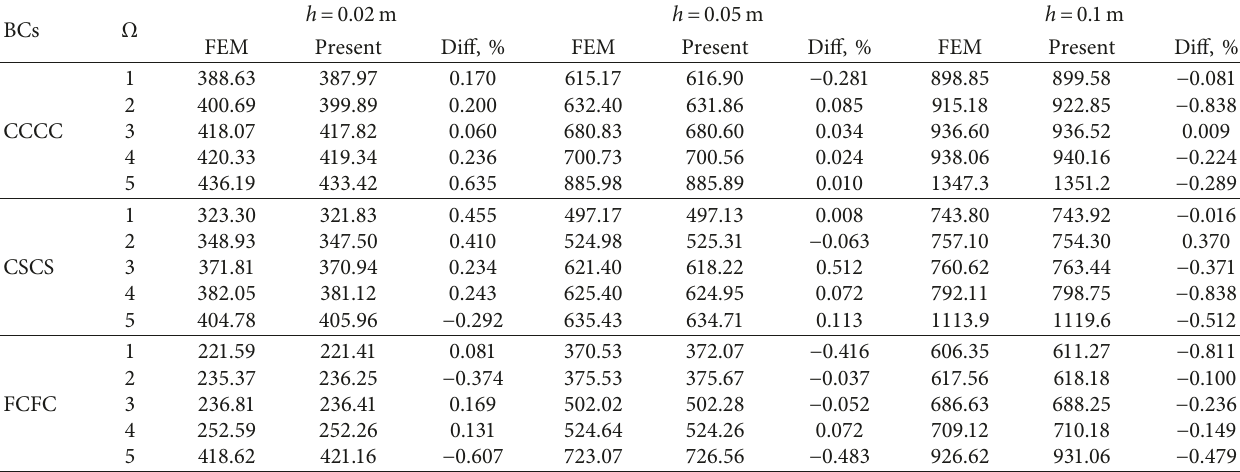
Table 5: Comparison of first five natural frequencies (Hz) for FGM